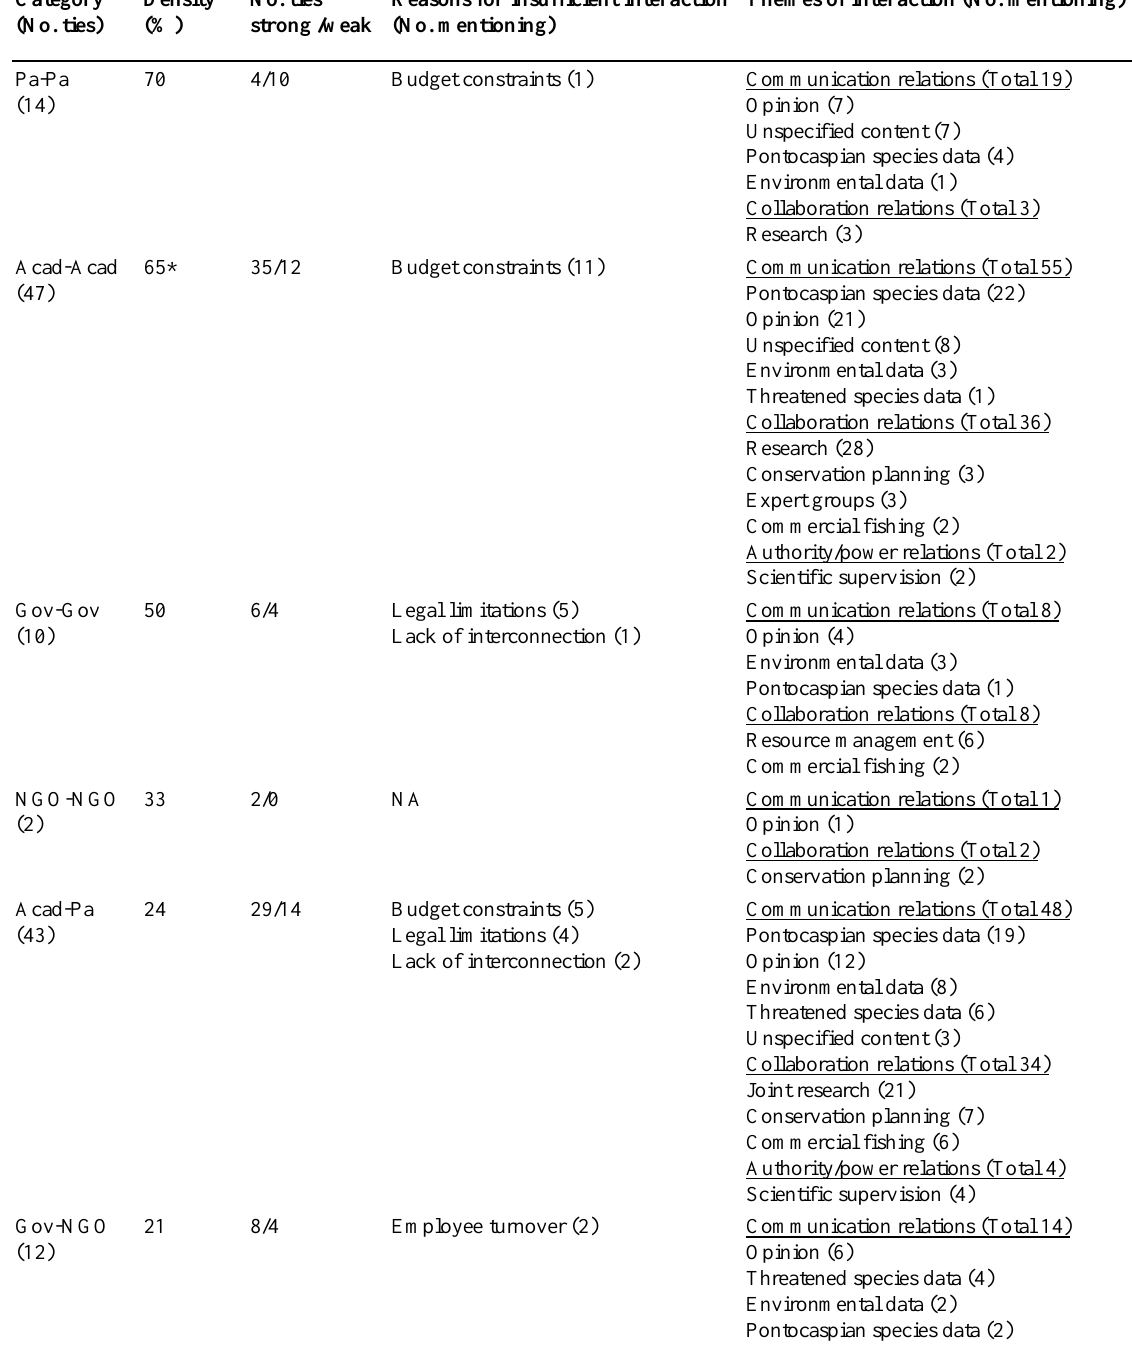
Table A2.4. Stakeholder group relations. Values in brackets under ‘Category’ report the number of ties within or between stakeholder groups. An * indicates significant difference from random expectation at 5% level according to the null-model